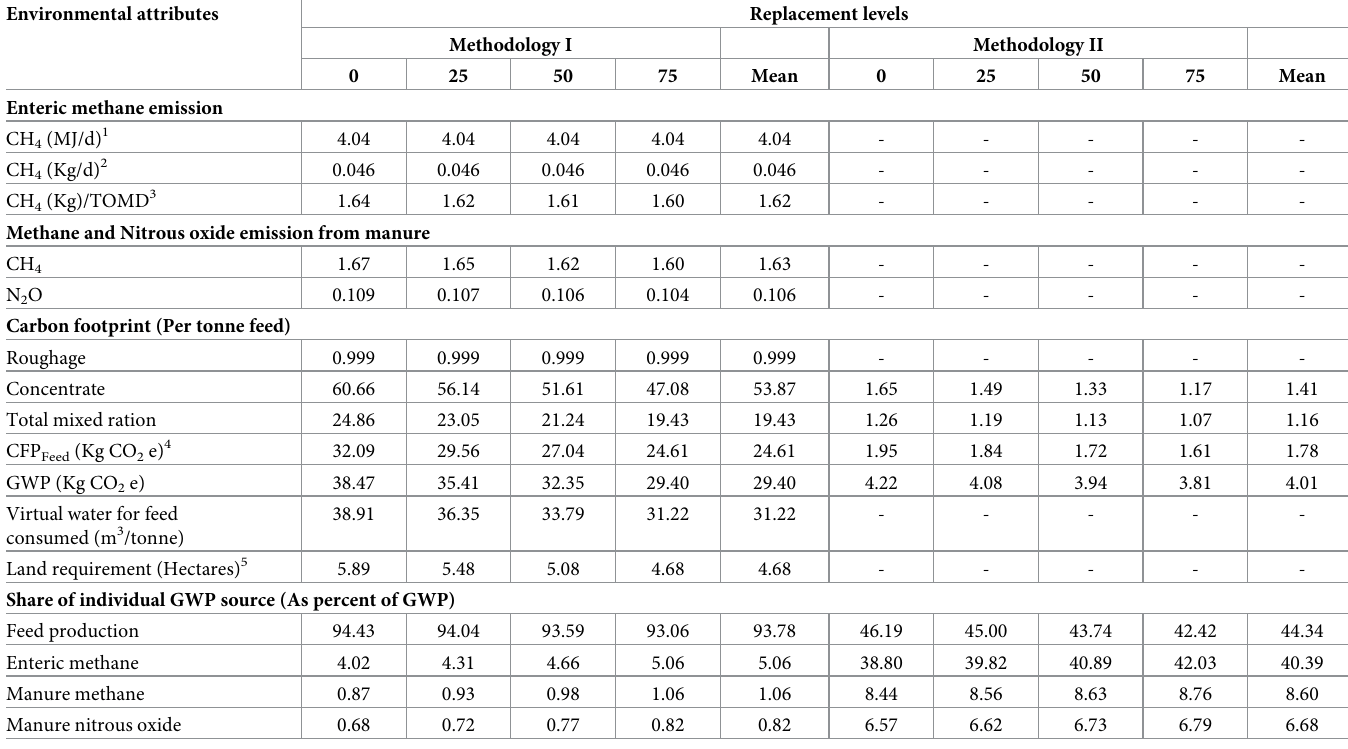
Table 6. Effect of replacing soybean meal with SRU on environmental attributes. Environmental